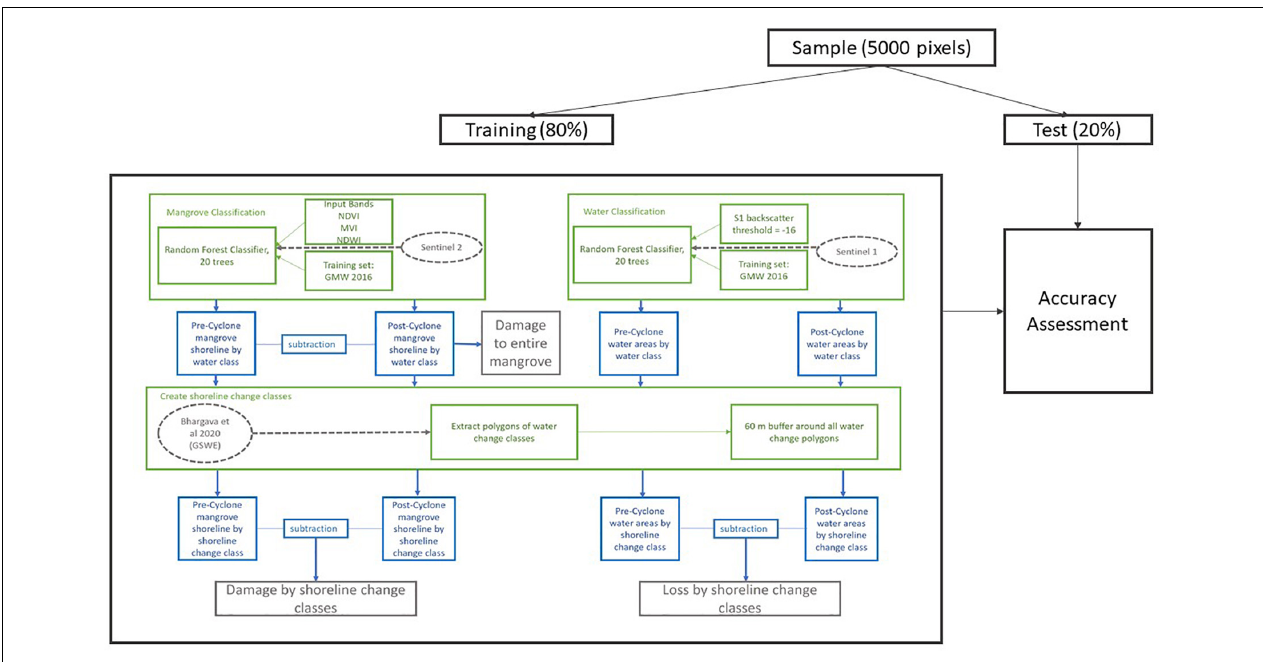
FIGURE 2 | Data collection and analysis framework for assessing mangrove forest and shoreline retreat. TABLE 2 | Range and number of Sentinel 1 (S1) and Sentinel 2 (S2) imageries used to create the pre-and post-cyclone composite scenes (for specific dates refer to Supplementary Table A ). Cyclone Date of occurrence Pre-cyclone composite (date range and